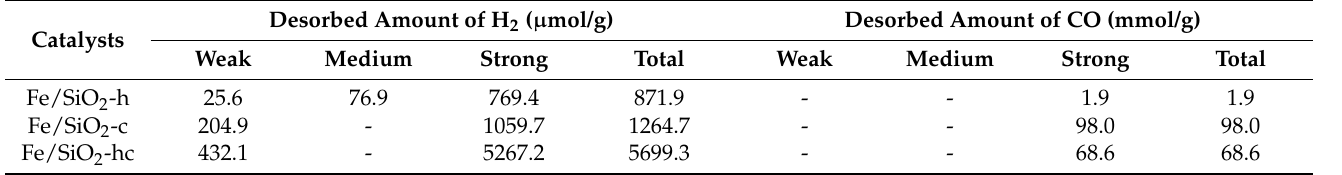
Table 2. The amount of H 2 and CO calculated from H 2 -TPD and CO-TPD profiles of all activated Fe/SiO 2